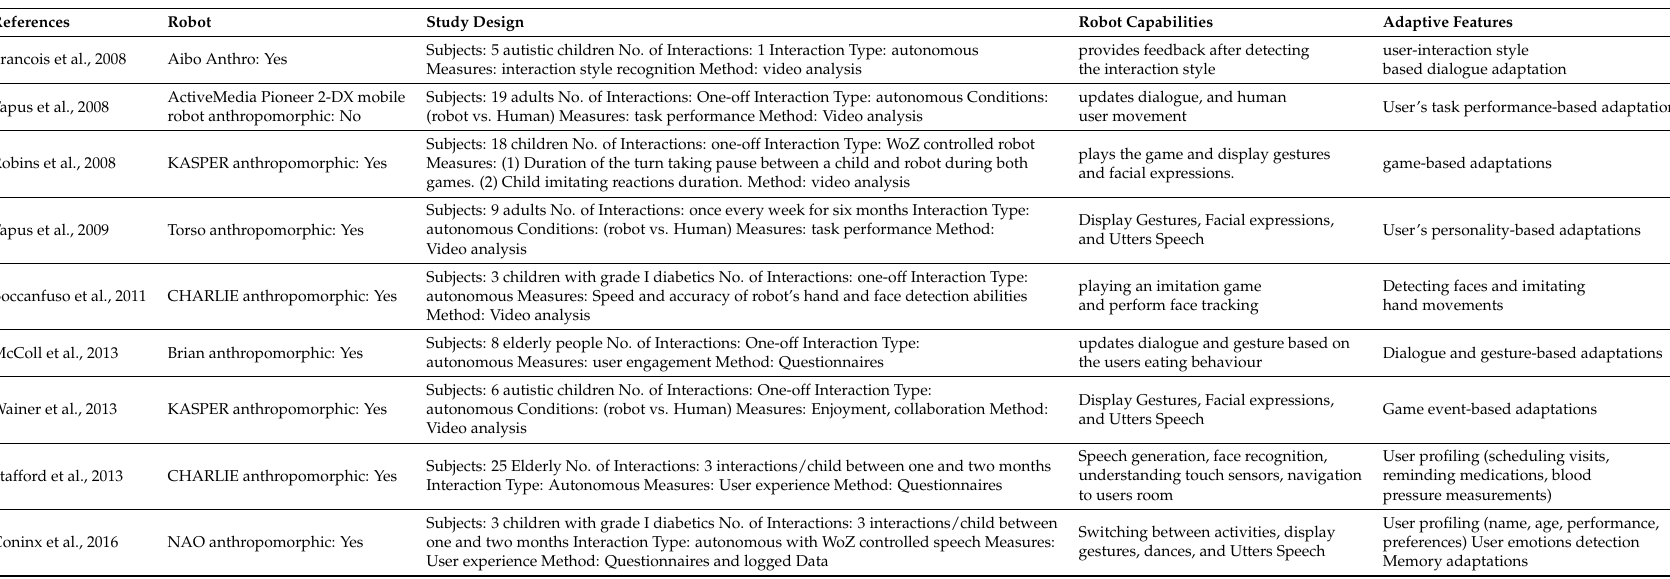
Table 1. Summary of Adaptive Interaction studies in the health care and therapy